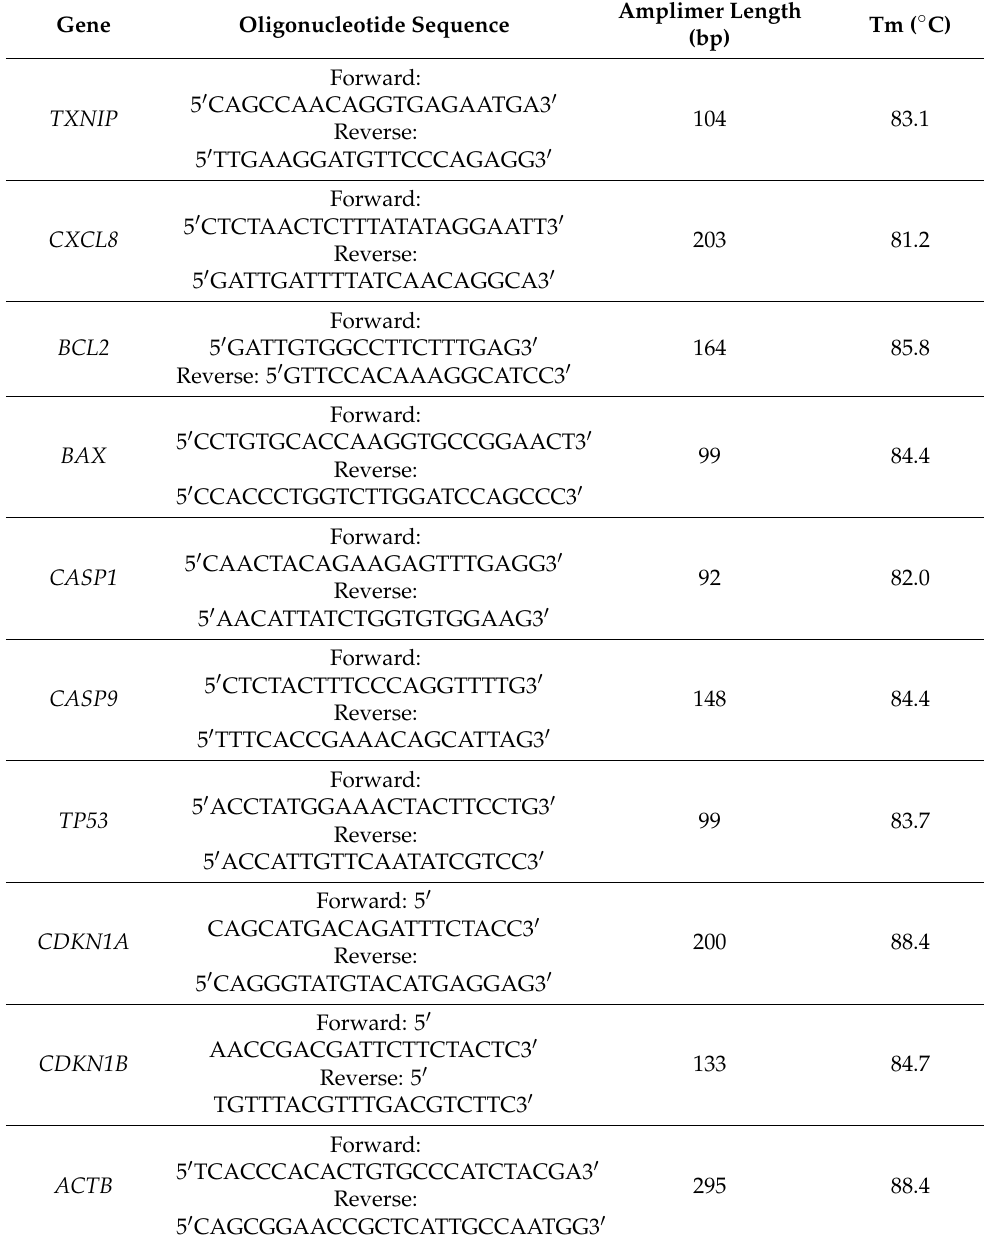
Table 1. Primer sequences for amplification of TXNIP , CXCL8 , BCL2 , BAX, CASP1, CASP9, TP53, CDKN1A , and CDKN1B